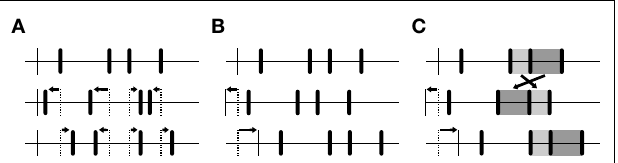
FIGURE 3 |Three different ways of creating surrogate data for testing the significance of coordinated events in parallel time series. Top traces depict original event trains, subjacent traces depict surrogate trains that have been derived from the original data (thin vertical bars: onset). (A) The time of every individual event is dithered randomly and independently on a certain scale, thereby destroying the temporal structure contained across as well as within event trains up to that scale. (B) Whole event trains are shifted randomly against each other, in that way eliminating coordination of events up to the corresponding timescale while preserving the full auto-structure. (C) Same as in (B) , but with additional random shuffling of consecutive inter-event intervals that are equal to or shorter than the maximal allowed shift (highlighted in light and dark